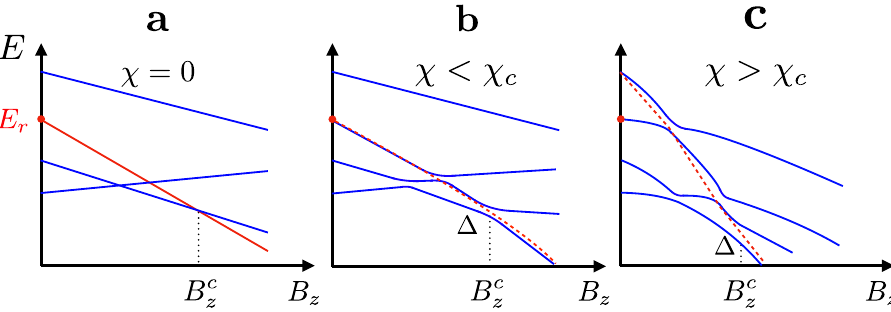
Fig.2|SpectrumandLandau – Zenertransition. AsketchofthespectrumofEq.(3)fordifferentvaluesoftheslope χ = B x / B z .ThereddotsrepresenttheSKenergyofthe referencestate. a Theredlinedepictstheenergyofthereferencestate. b , c Thereferencestateistheeigenstateonlyat B z = B x =0.Thereddashedlineindicatesadiabatic trajectory of step 3, undergoing Landau – Zener transition (from large B z to small B z